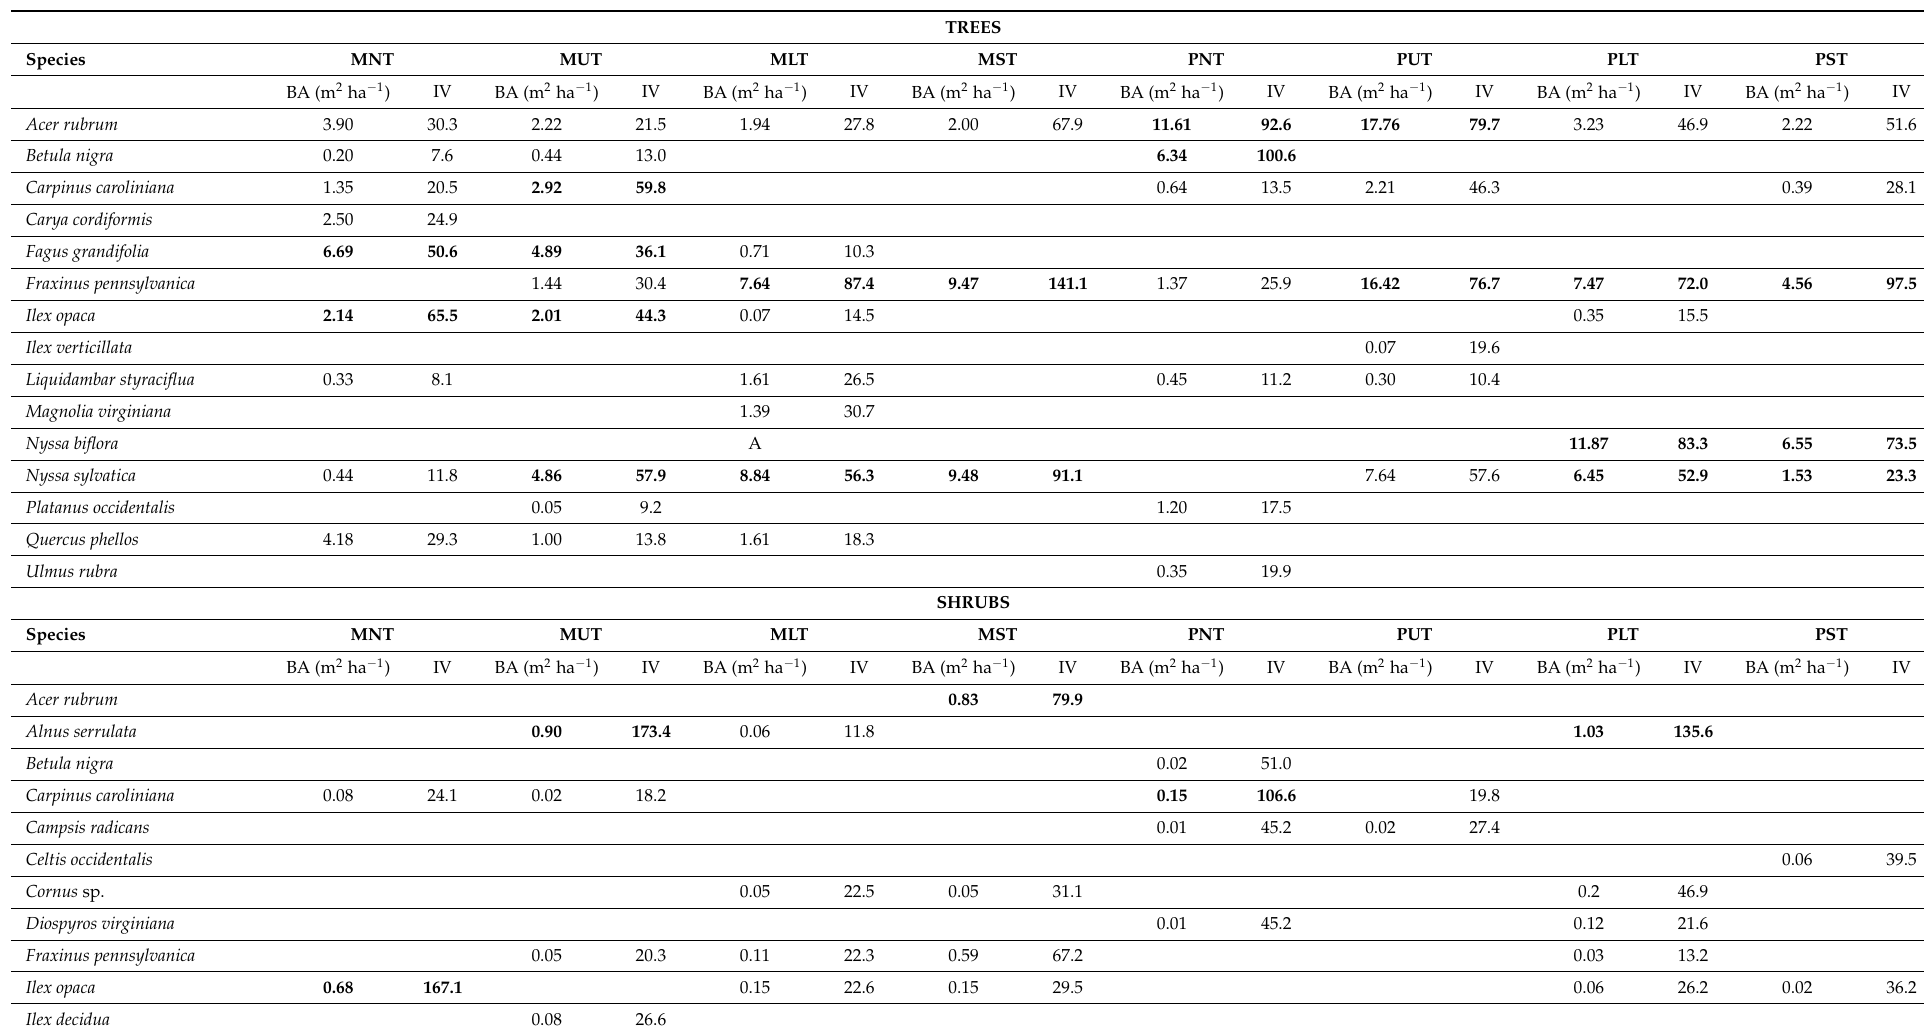
Table 2. The most common species based on basal area and importance value (IV) at each study site in the canopy tree (top) and shrub and understory tree layers (middle), and the herbaceous layer species (bottom) with ≥ 5% average percent cover at one or more sites, along with their IVs. Bold fonts indicate high